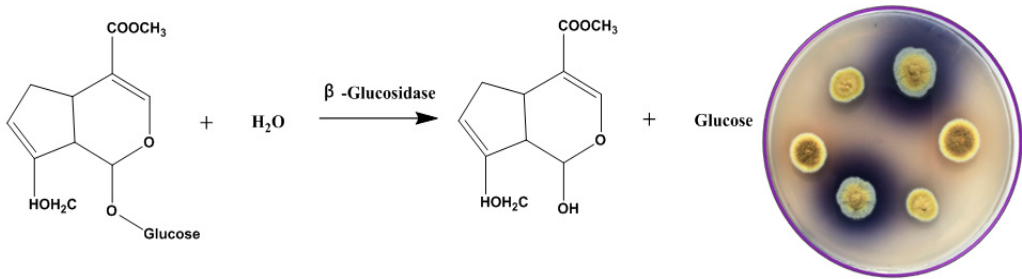
Figure 3. Biotransformation of geniposide into genipin by Eurotium sp. The plate on the right shows the colony morphology of E. amstelodami BSX001 on the selective medium with gardenoside as sole carbon source. Colonies with a larger blue circle had a higher glycosidase activity.